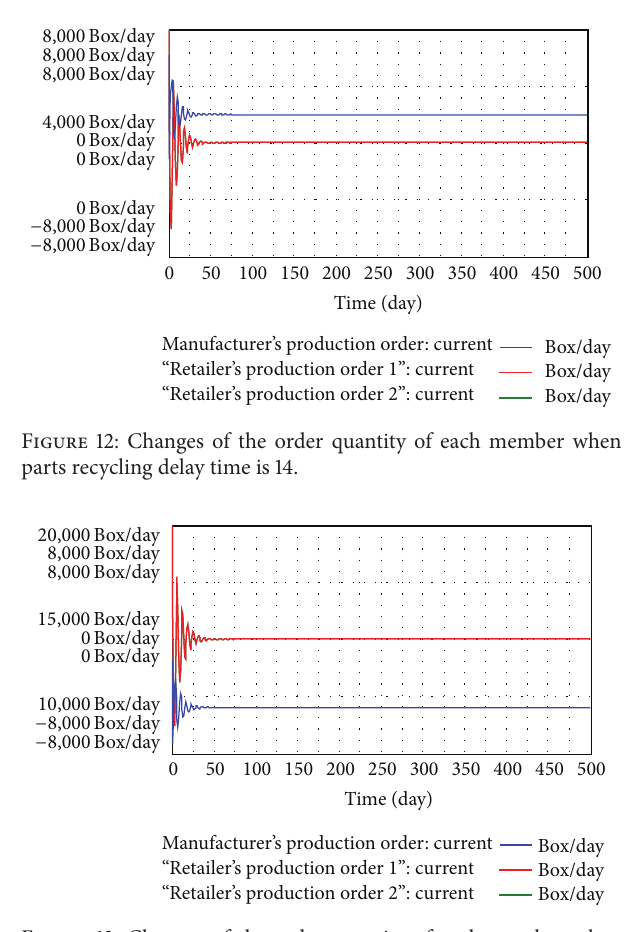
Figure 13: Changes of the order quantity of each member when parts recycling delay time is 21.